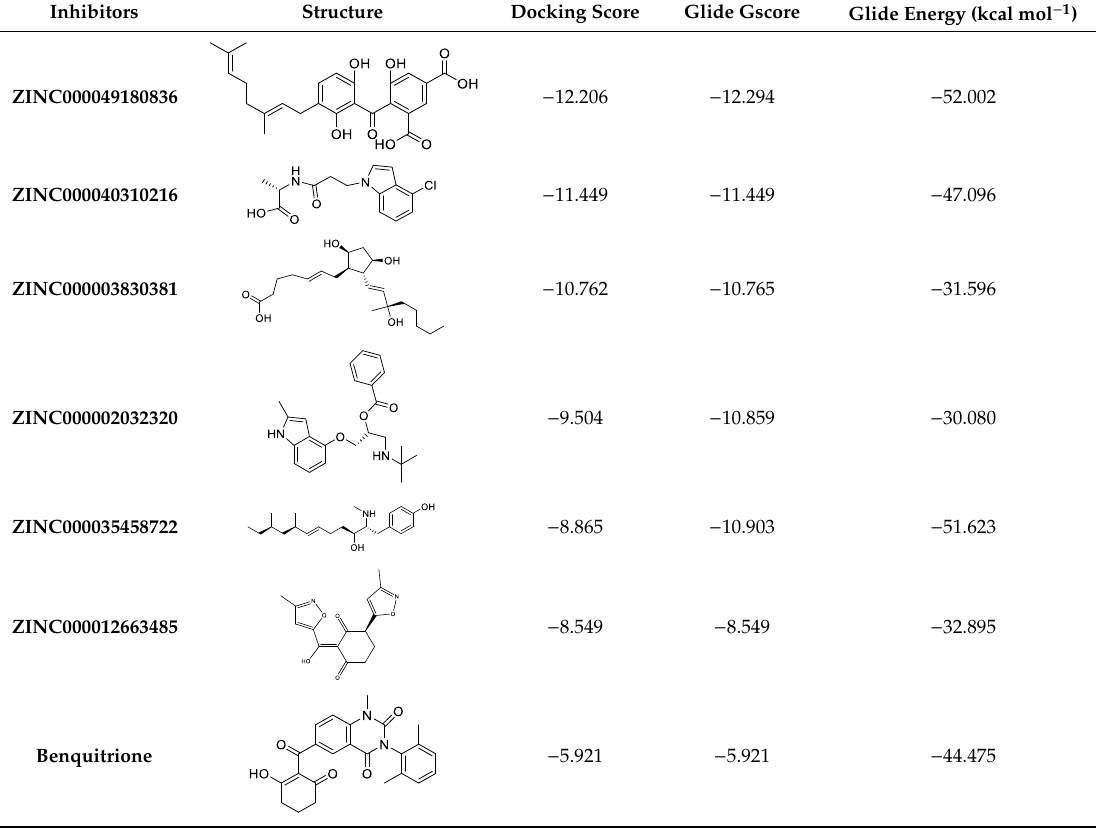
Figure 6. Ligand compared by the glide method. Redocked ligand was green and the native ligand in the crystallographic complex was blue. Table 3. Two-dimensional structure of the potential HPPD Inhibitors and the evaluation value.